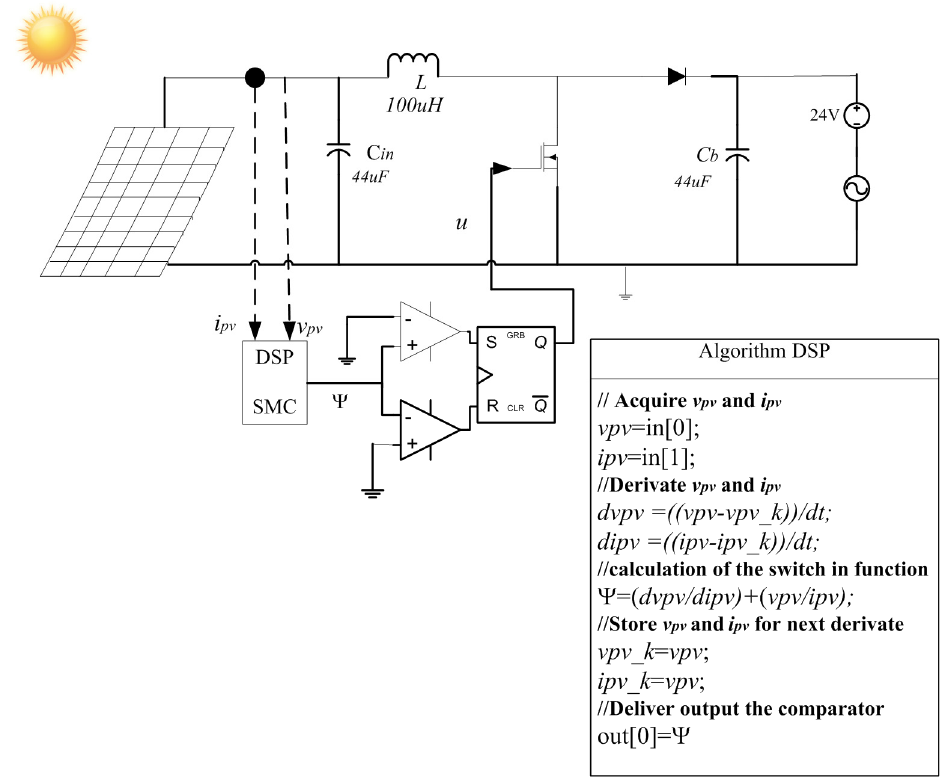
Figure 12. Simulation scheme and SMC implementation.